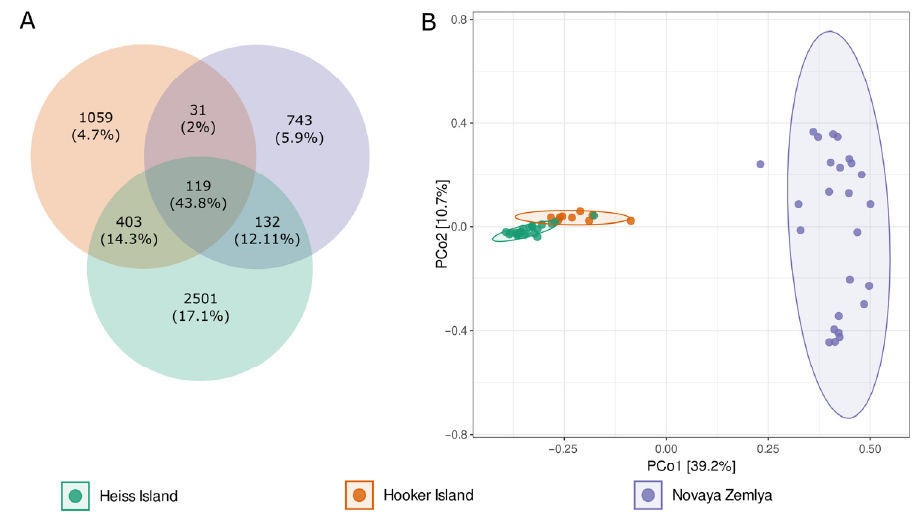
Figure 3. ( A )—Venn diagram of the core, shared and island-specific ASVs for three islands involved in the study, ( B )—Principal coordinates analysis (PCoA) ordination of variation based on weighted Bray–Curtis dissimilarity.